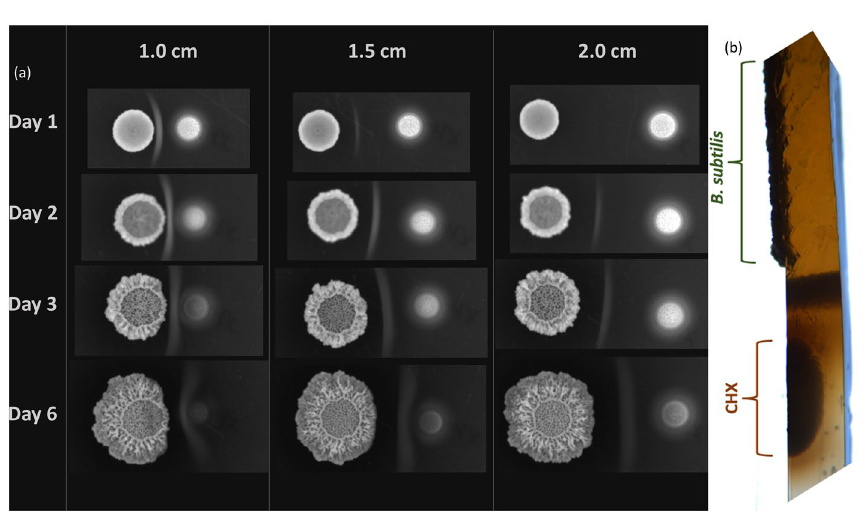
Figure 7. Bright field images of expanding macrocolonies. ( a ) Bright field images of expanding B. subtilis macrocolonies grown in proximity to CHX at 1/1.5/2 cm. CHX droplet is seen to the right of the macrocolonies. ( b ) Cross-section of agar substrate seeded with a macrocolony and CHX